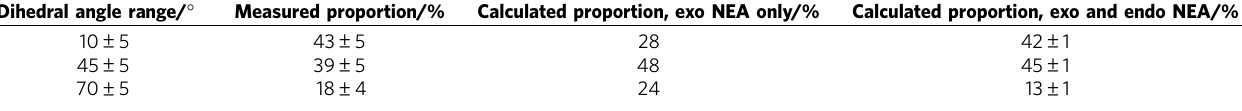
Measured proportions of NEA–MP docking complexes that have dihedral angles in the STM images between the naphthyl group of NEA and the long axis of the MP of 10 ± 5, 45 ± 5 and 70 ± 5 (cid:2) , compared with the results of the image analysis of the structures of the docking complexes calculated using DFT for only the exo form of NEA, and then including both the endo and exo forms. The measured proportions include the sampling error and the calculated proportions take into account possible variations in the sample temperature.